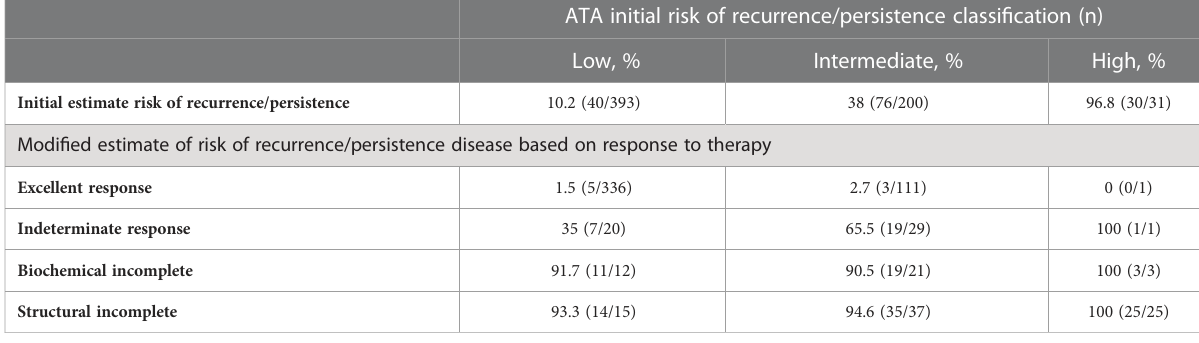
TABLE 5 Impact of response to initial therapy assessment on initial estimates of